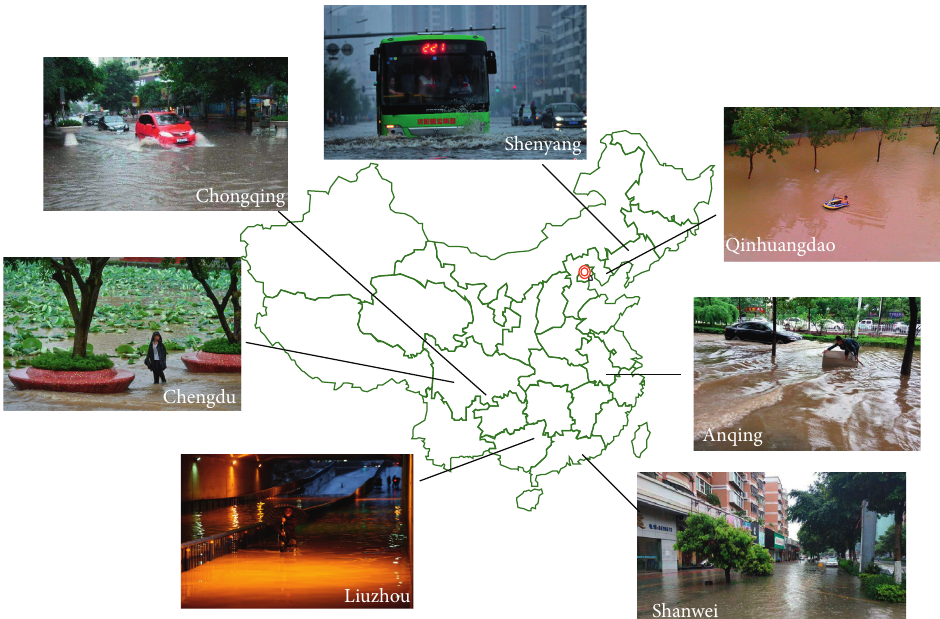
Figure 1: Flooding ravaged in many Chinese